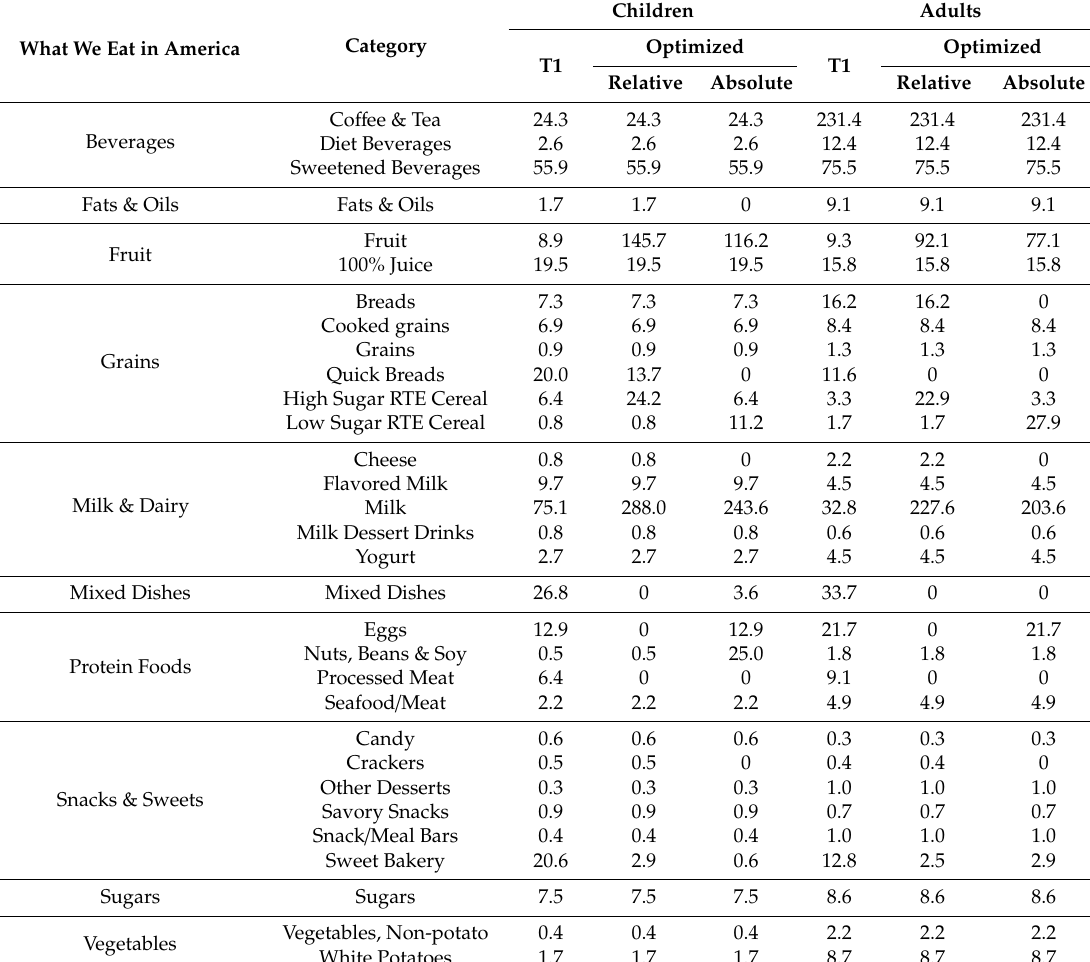
Table 2. Comparisons in food composition of T1 breakfasts and the two LP models. Consumption measured in g / day. Data are presented separately for children and adults. NHANES 2011–14 United